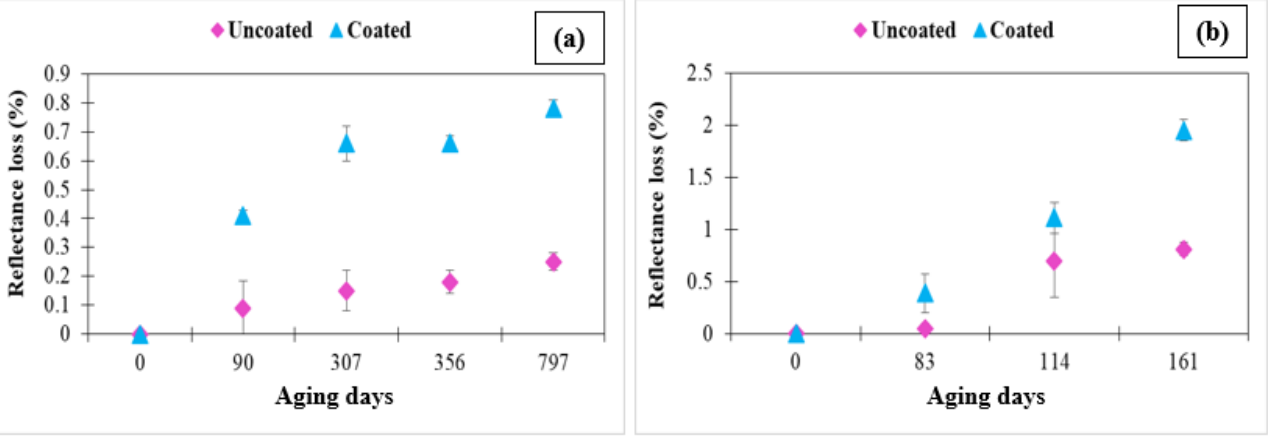
Figure 13. Specular reflectance loss of coated and uncoated samples exposed on ( a ) desertic and ( b ) coastal sites.